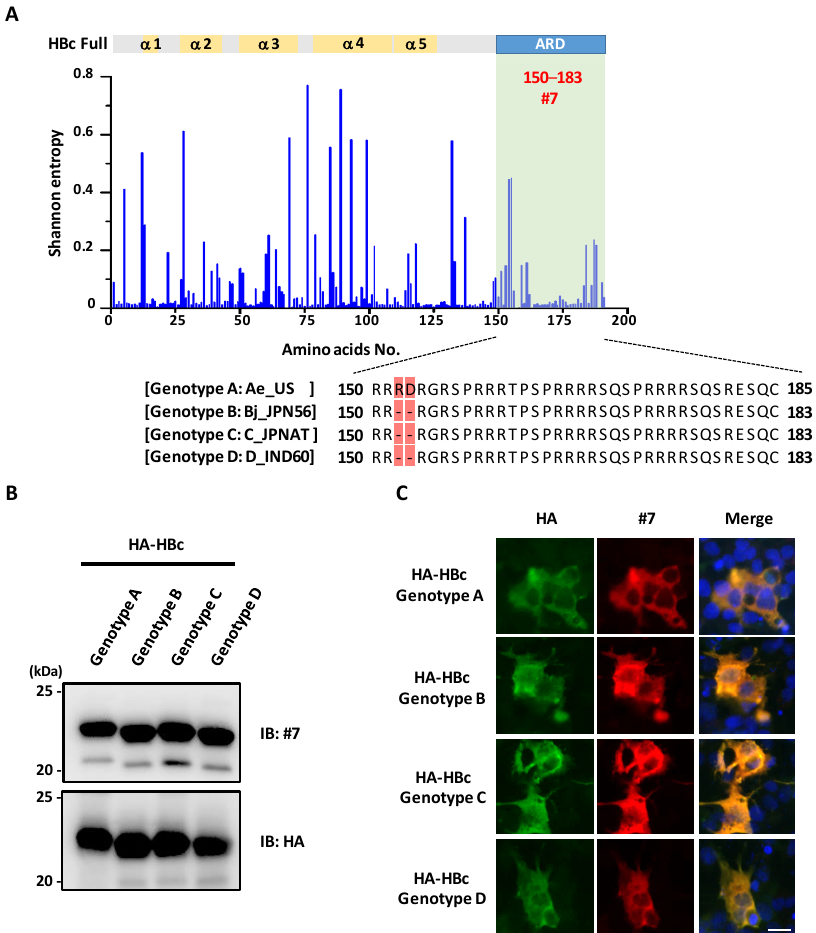
Figure 4. mAb #7 detects HBc derived from multiple HBV genotypes. ( A ) Shannon entropy was calculated for each amino acid residue of HBc derived from 13,893 strains (upper panel). The mAb #7 binding region is represented in green. Multiple alignment of sequences in HBc ARD derived from genotypes Ae_US, Bj_JPN56, C_JPNAT, and D_IND60 (lower panel). The substituted amino acids are highlighted in red. ( B ) Recombinant HA-HBc (HBV genotypes A, B, C, and D) were synthesized using a wheat germ cell-free system and analyzed by immunoblotting with mAb #7 or anti-HA antibody. ( C ) HepG2 cells transfected with HA-HBc (HBV genotypes A, B, C, and D) were fixed with 4% PFA and stained with mAb #7 (red) or anti-HA antibody (green), and then counterstained with DAPI (blue). Scale bar, 10 μ m.